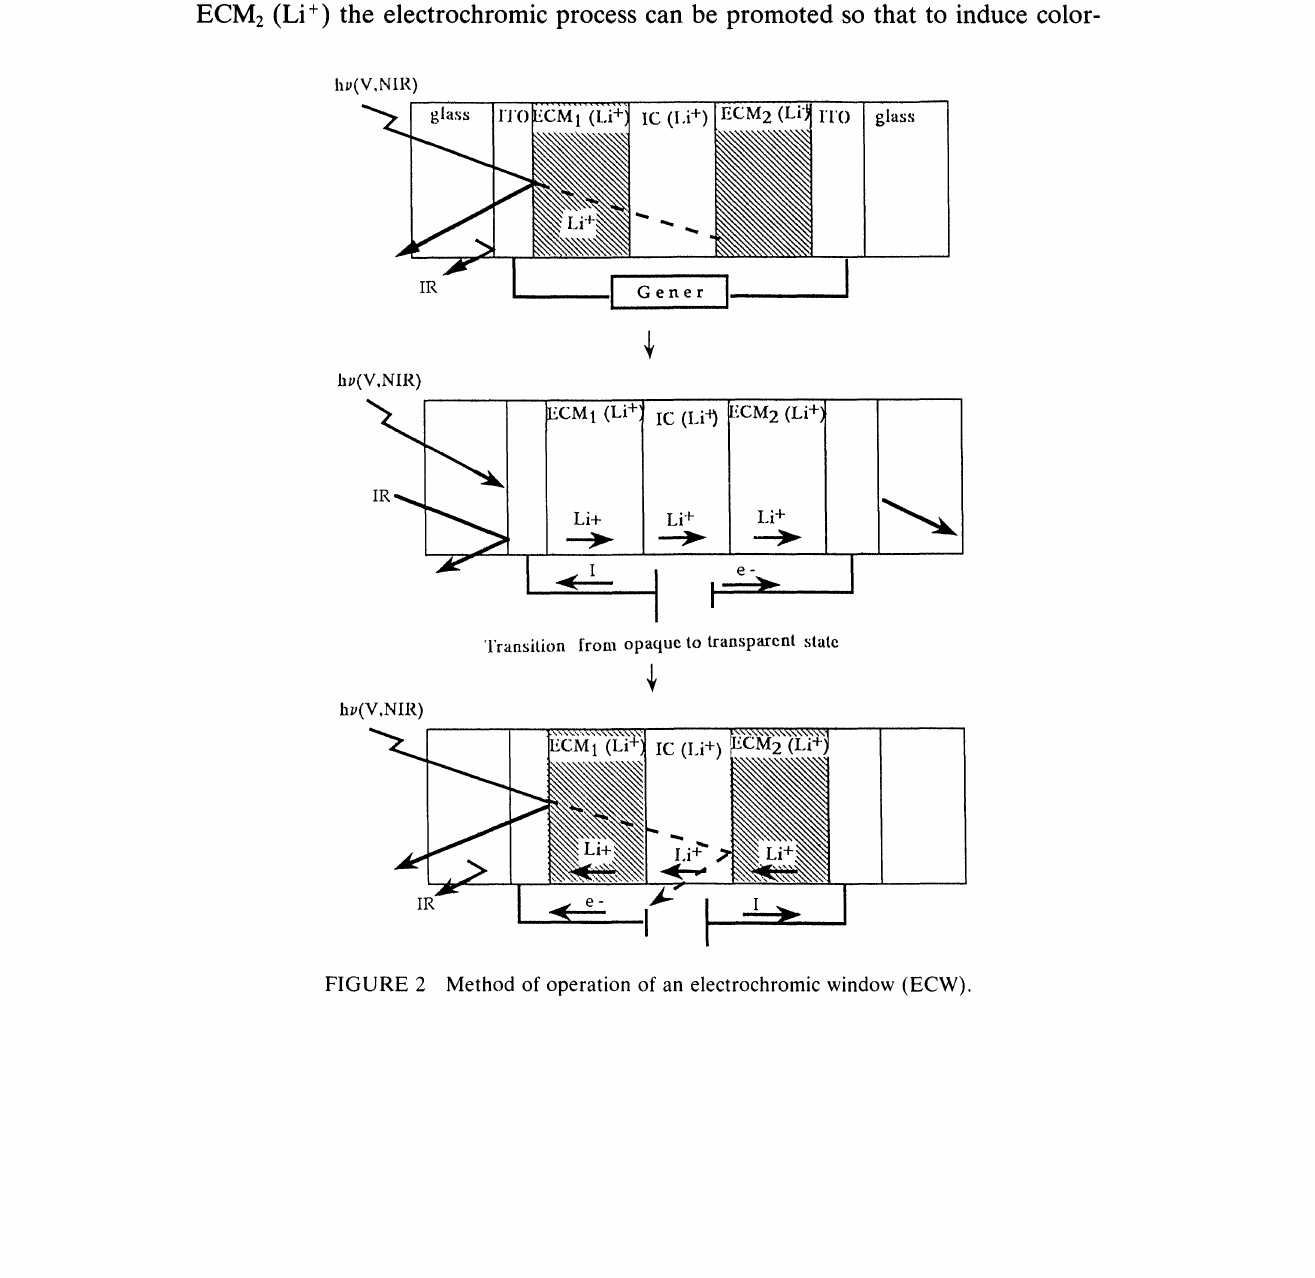
FIGURE 2 Method of operation of an electrochromic window